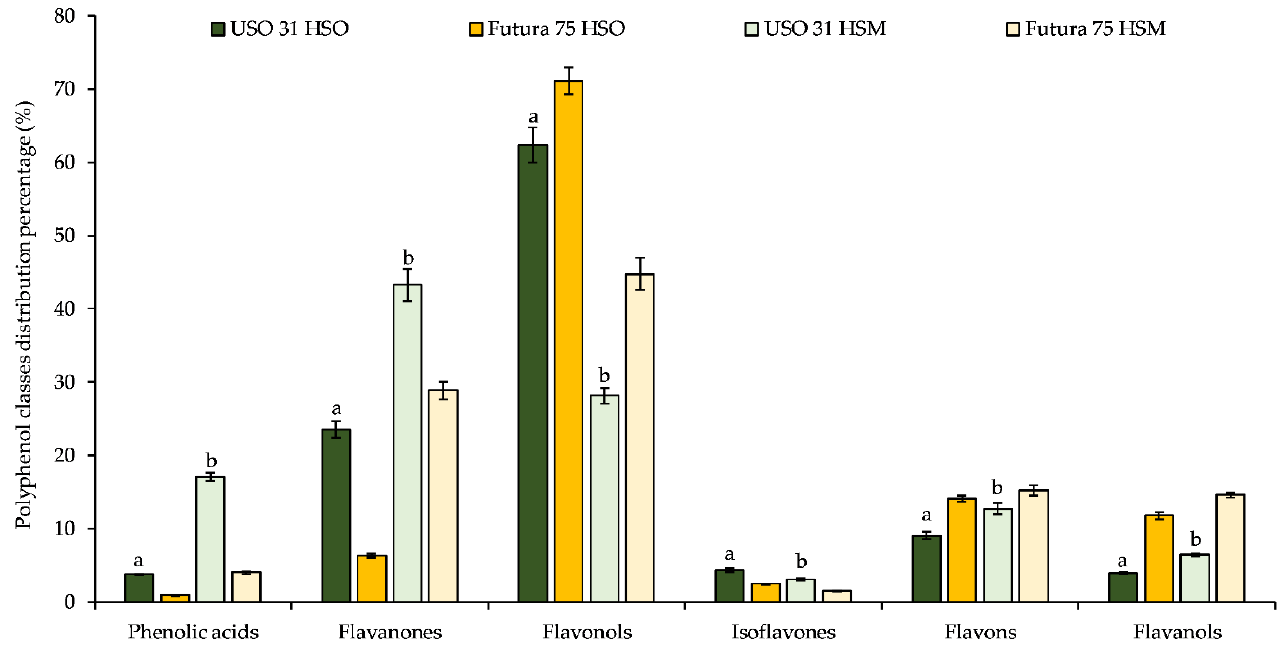
Figure 1. Percentage distribution of the different classes of polyphenols identified in USO 31 and Futura 75 hempseed oil (HSO) and hempseed meal (HSM). a p < 0.05 vs. Futura 75 HSO; b p < 0.05 vs. Futura 75 HSM.